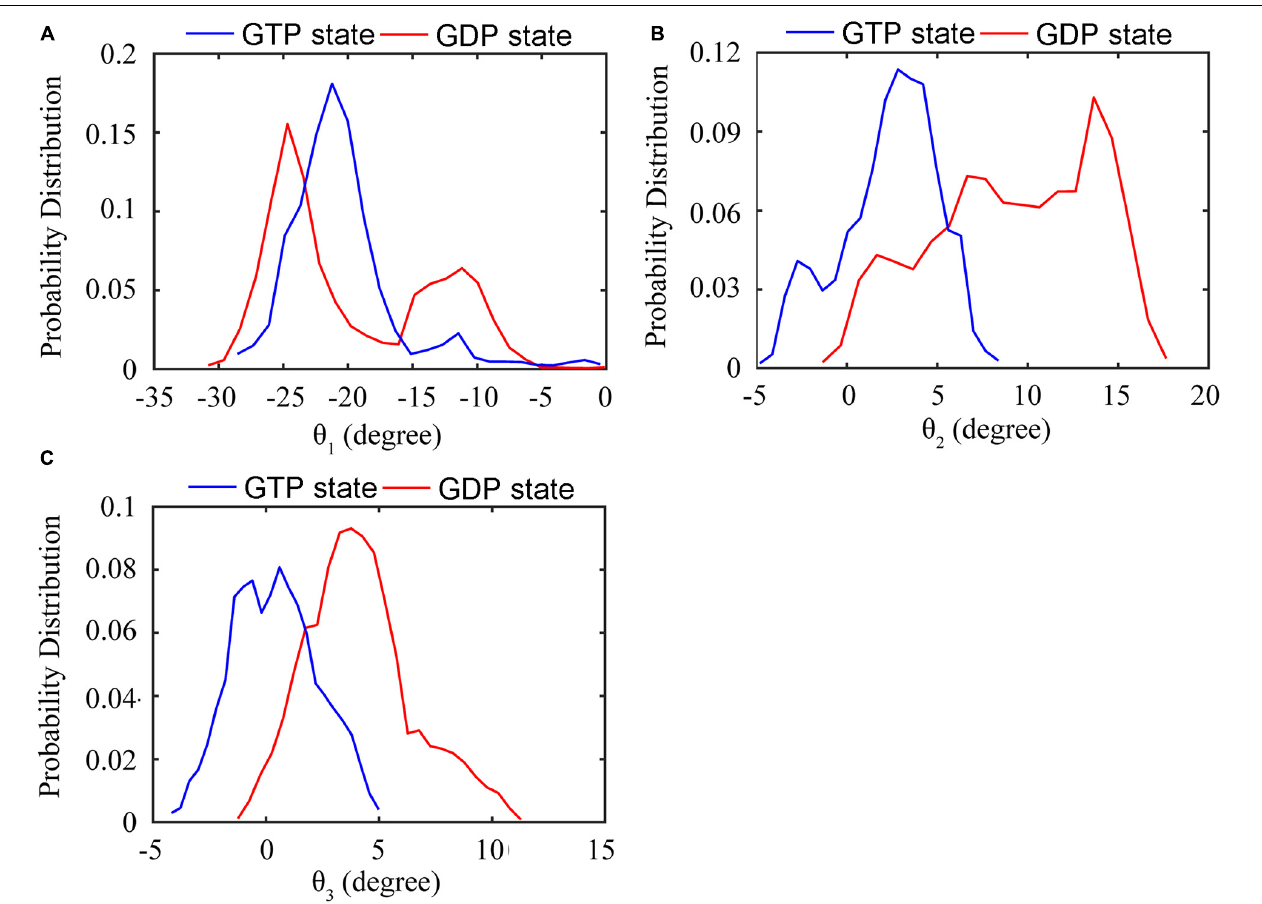
FIGURE 5 | Distribution of the relative rotation angles between subunits in the GTP- (blue) and GDP-bound (red) trimers. (A) Twisting motion around θ 1 . (B) Bending motion around θ 2 . (C) Bending motion around θ 3 . In all the cases, the rotation angles are calculated by averaging both top and bottom interfaces over all GTP-bound (two runs) or GDP-bound (three runs)